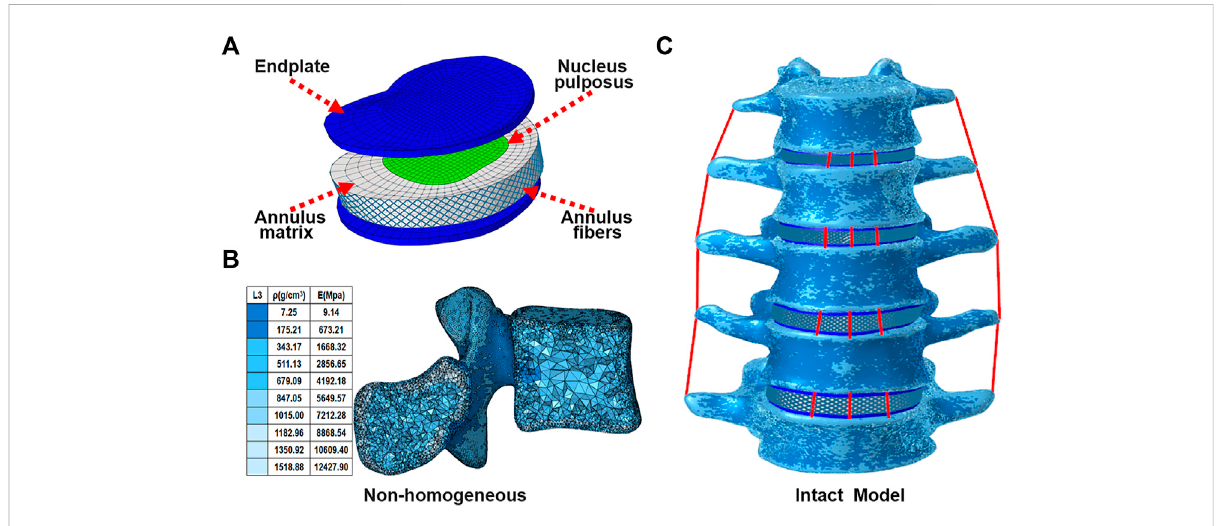
FIGURE 1 FE model of the lumbar spine: (A) Disc and endplate, (B) Vertebral body, (C)